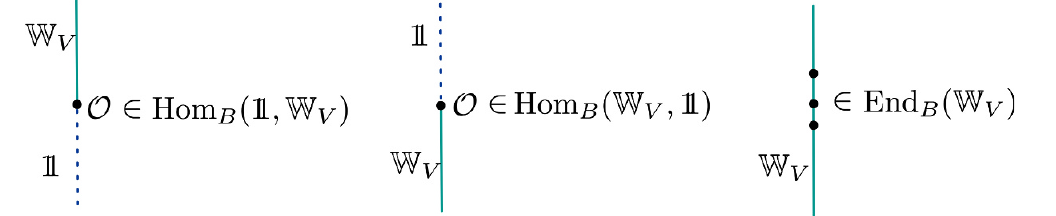
Figure 3 . Endpoints and endomorphisms of Wilson